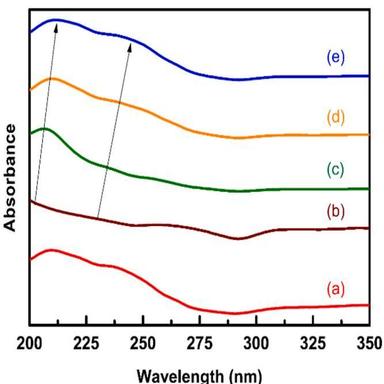
UV–Vis. absorption spectra of g-C3N4, CN-A and Al2O3 samples with various loadings: (a) g-C3N4; (b) 4.7CN-A; (c) 9CN-A; (d) 13CN-A; (e) 16CN-A.